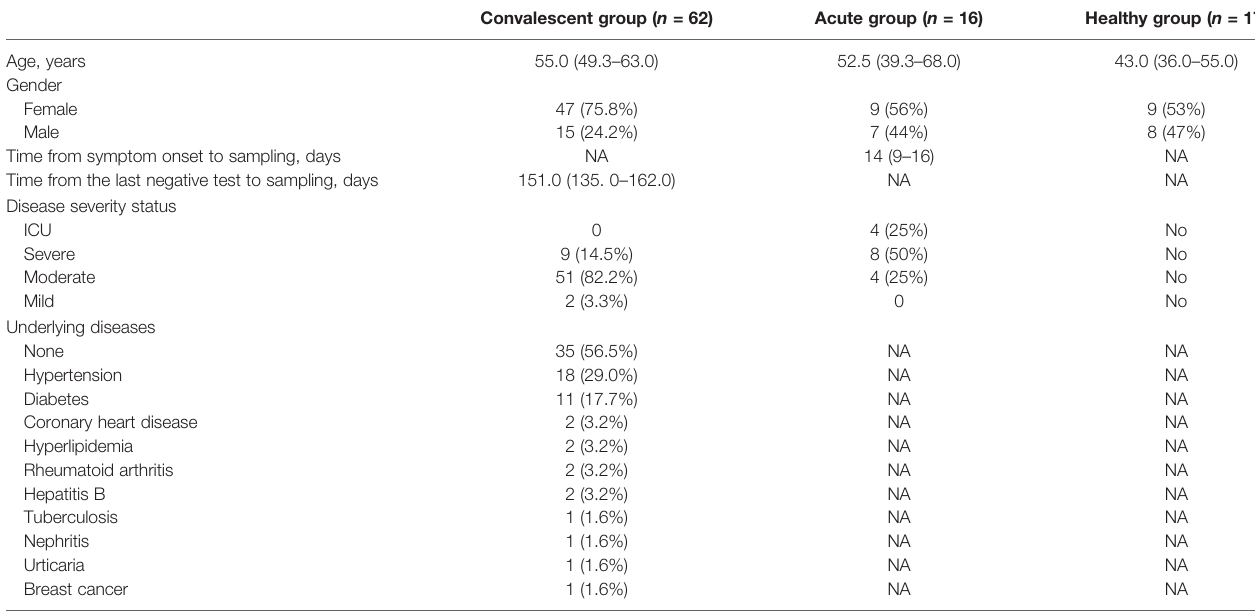
TABLE 1 | List of information of the